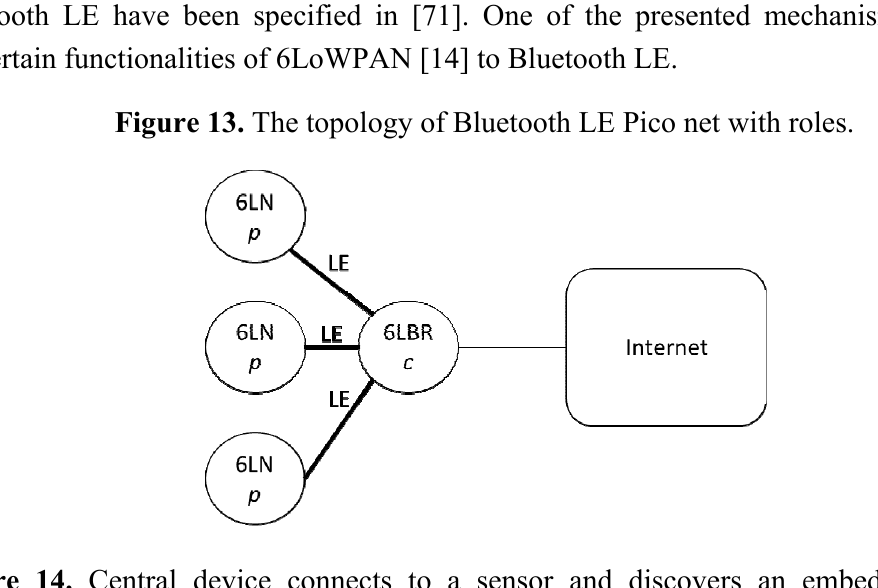
Figure 14. Central device connects to a sensor and discovers an embedded Internet services that was not advertised. The 6LBR may accept connections from many